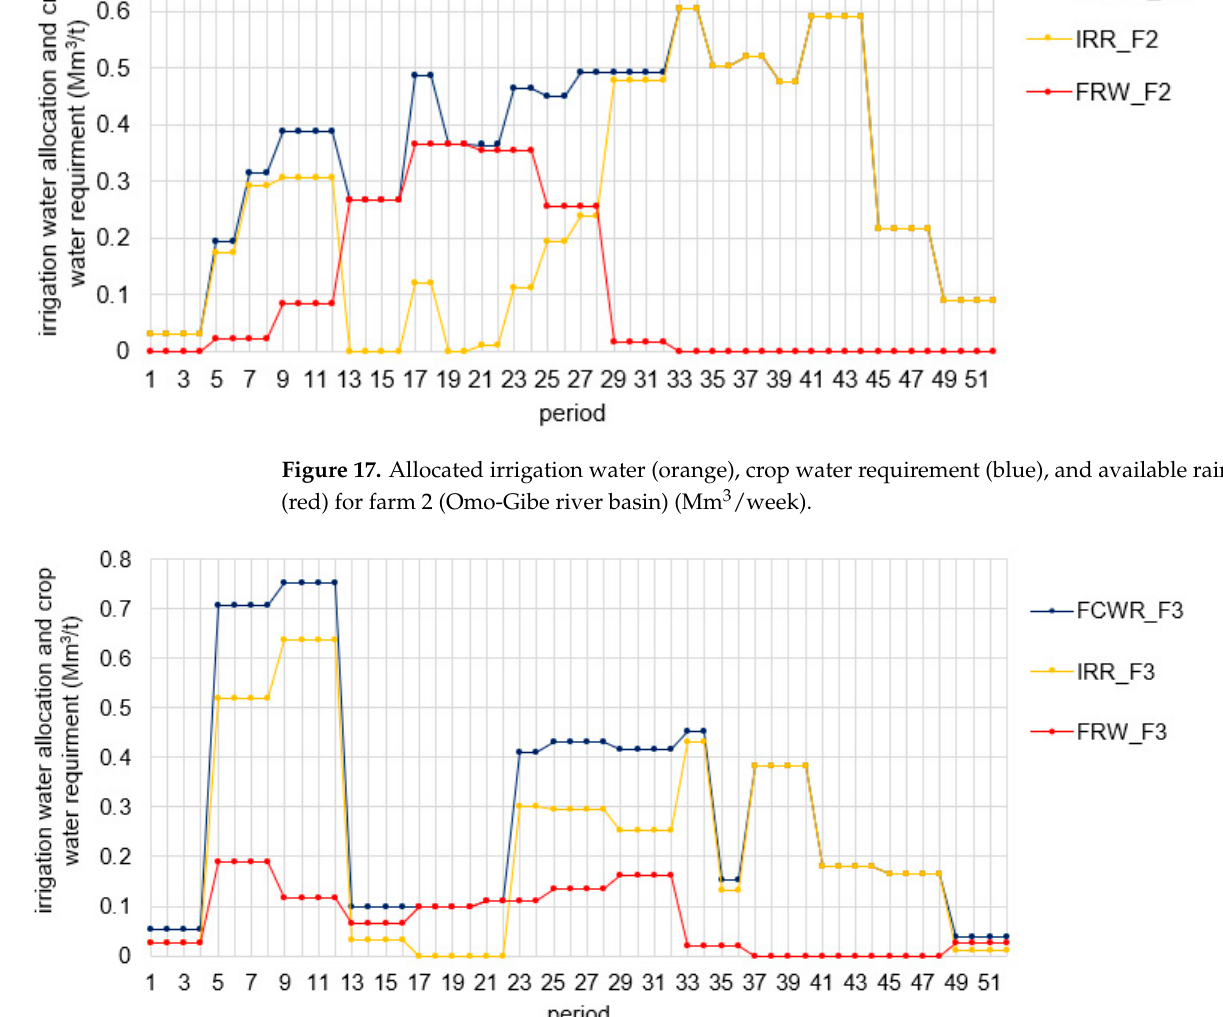
Figure 18. Allocated irrigation water (orange), crop water requirement (blue), and available rainfall (red) for farm 3 (Omo-Gibe river basin) (Mm 3 /week).